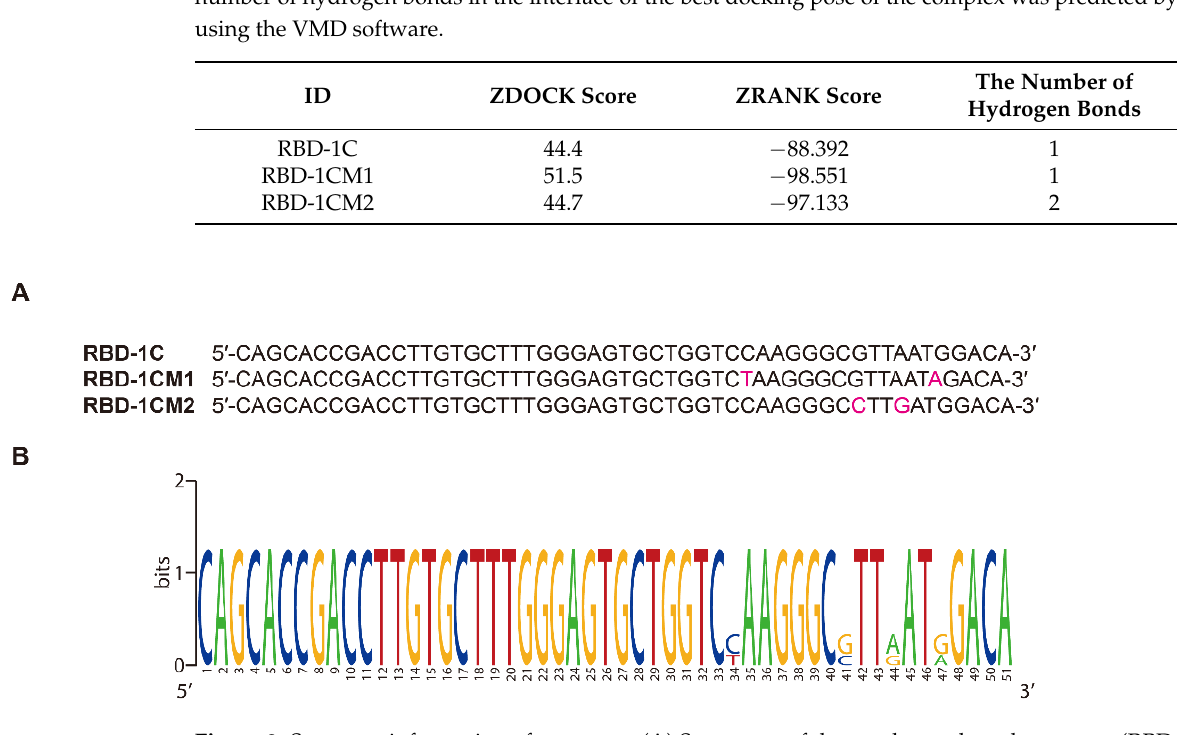
Figure 2. Sequence information of aptamers. ( A ) Sequences of the two best selected aptamers (RBD-1CM1 and RBD-1CM2) and RBD-1C aptamer. ( B ) Image of sequence alignment for three sequences (created by WebLogo) [29]. The mutated nucleotides are marked in this image.